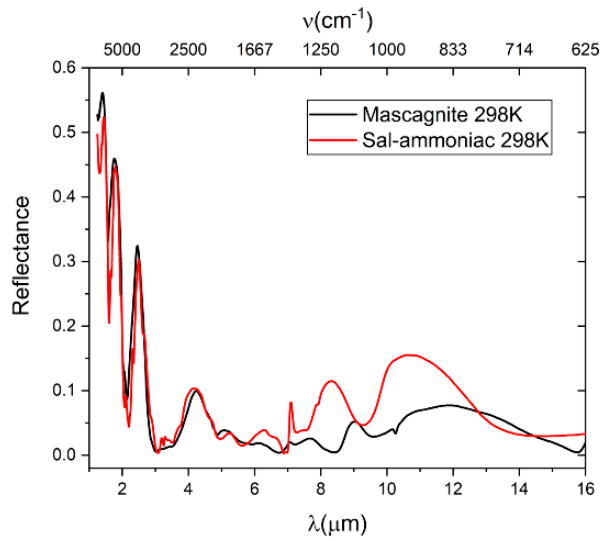
Figure 11. Comparison of the reflectance spectra for mascagnite and sal-ammoniac in the region of 1–16 μ m.